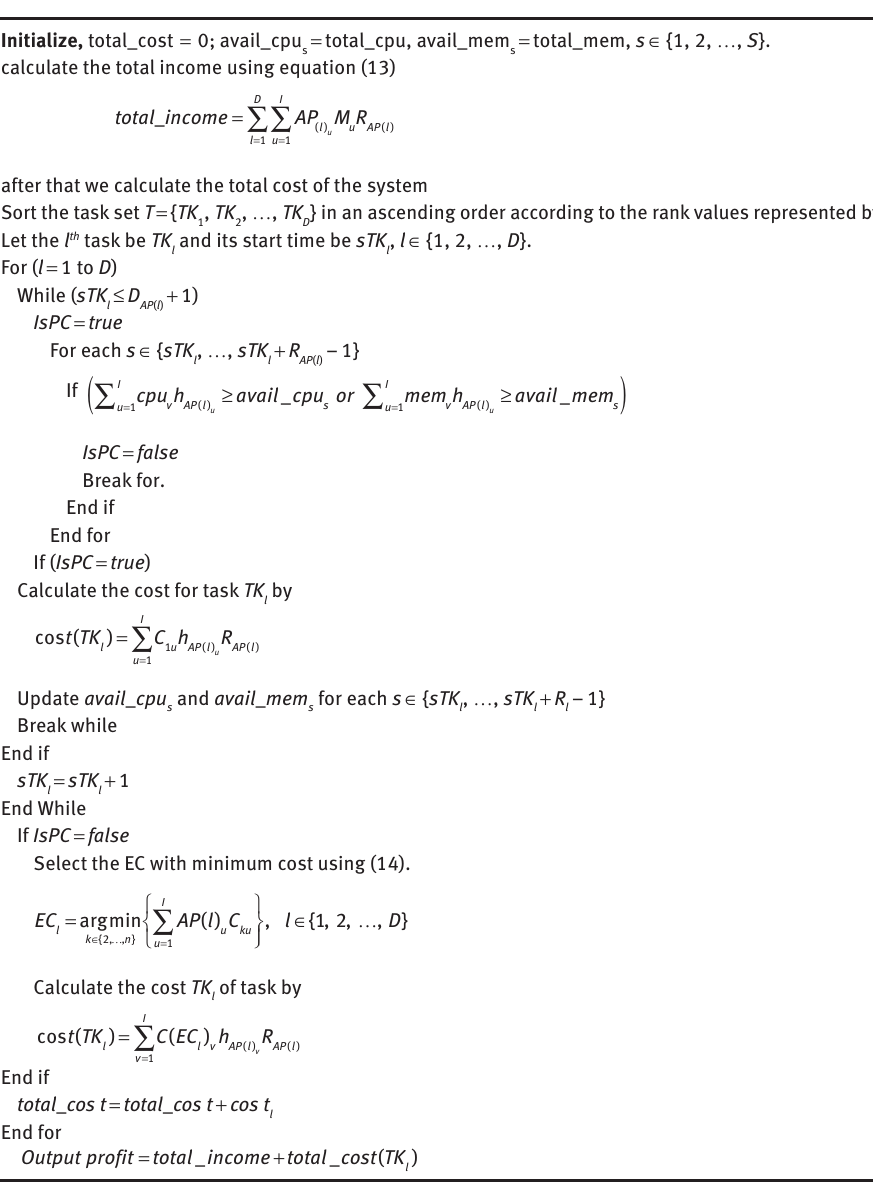
Table 3: Algorithm for Fitness